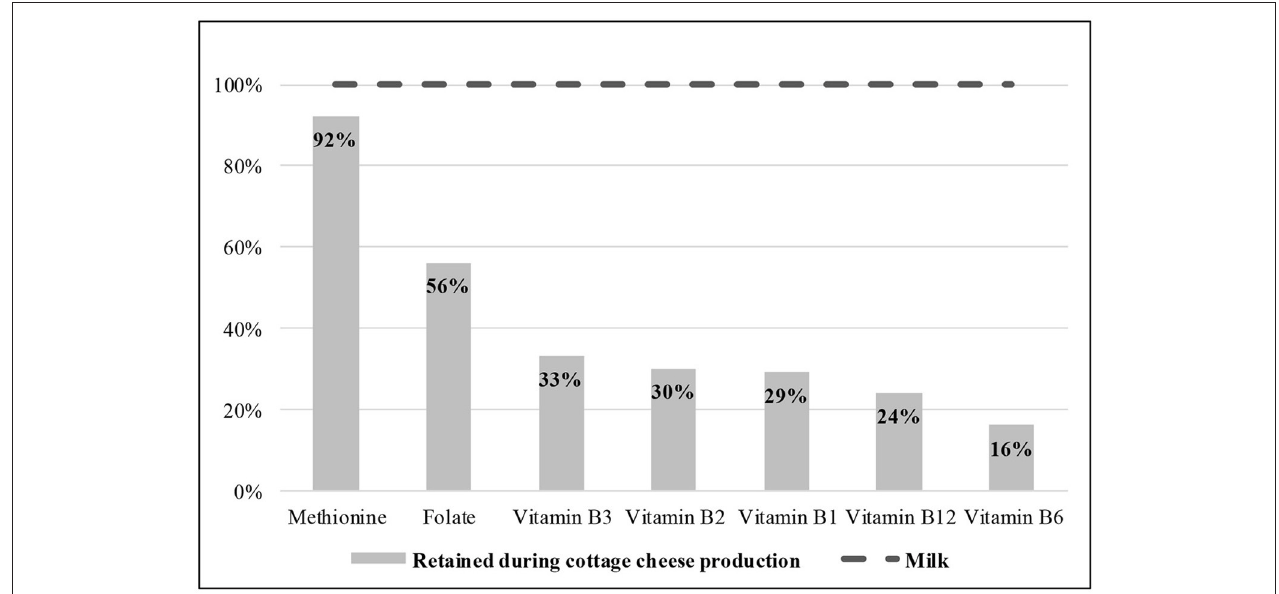
FIGURE 1 | Methionine and B-vitamins, % retained in cottage cheese (USDA ID: 01015) vs. milk (representing 100%). Adapted from Shapira (8) with permission from The Royal Society of